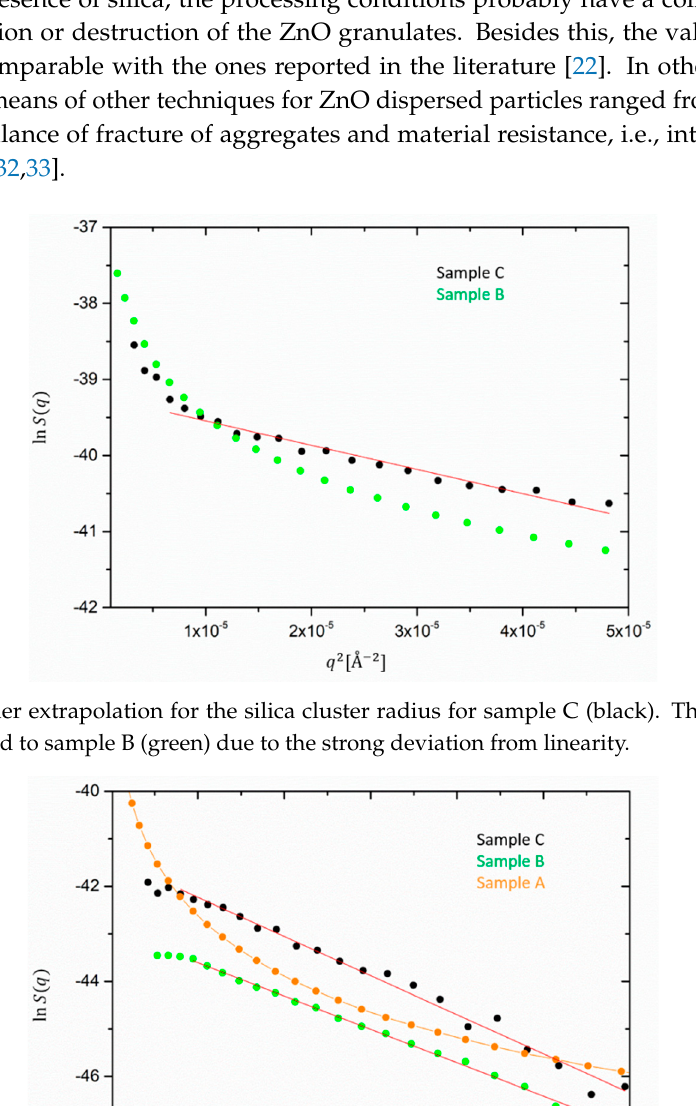
Figure 8. Guinier extrapolation of the ZnO radius for sample C (black) and B (green). Sample A (orange) clearly shows a deviation from the Guinier dependence.